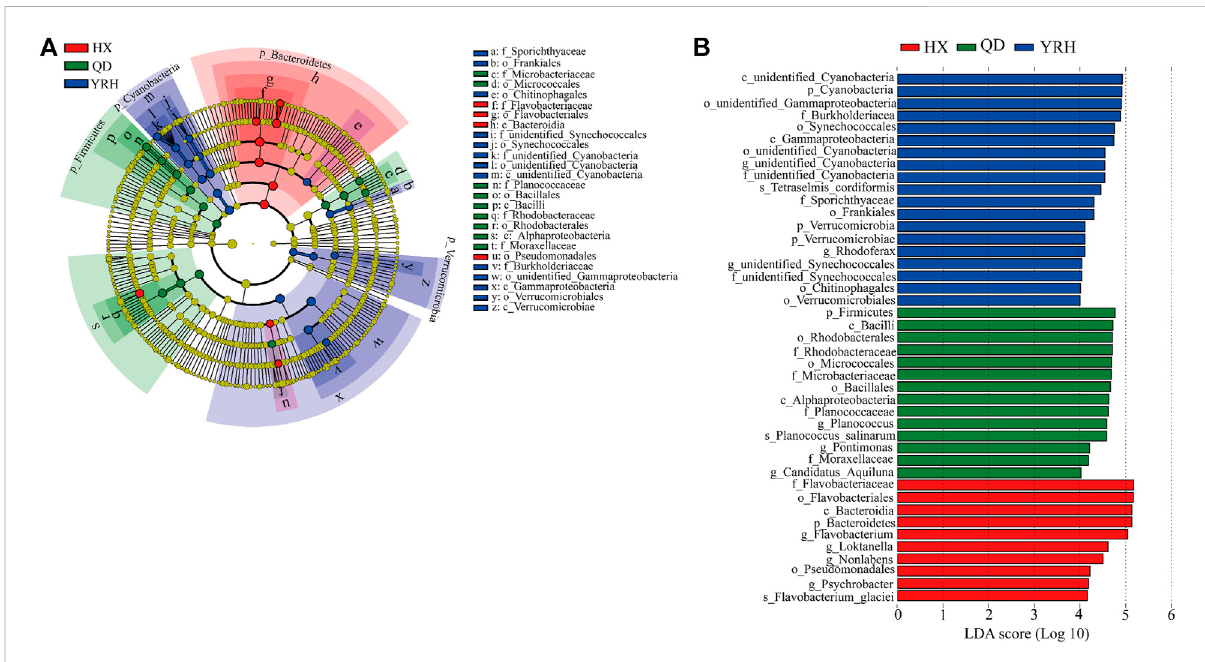
FIGURE 4 (A) :Taxacladogram comparisonofbacterialcommunitiesinthethree regions. (The circlesfrom innermost tooutermostrepresent thephylum level to the species level); (B) Linear discriminant analysis (LDA) of effective size of bacterial communities in the three regions.